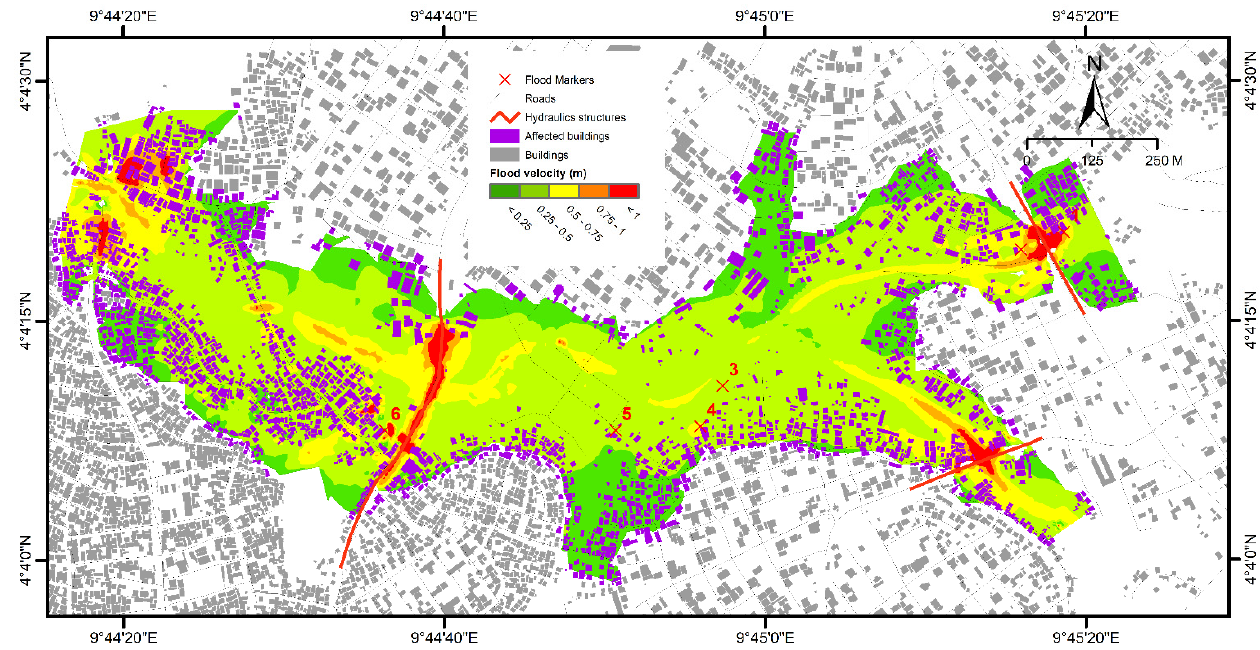
Figure 7. Flood velocity (m/s) within the “Makèpè Missokè” floodplain for the August 2020.